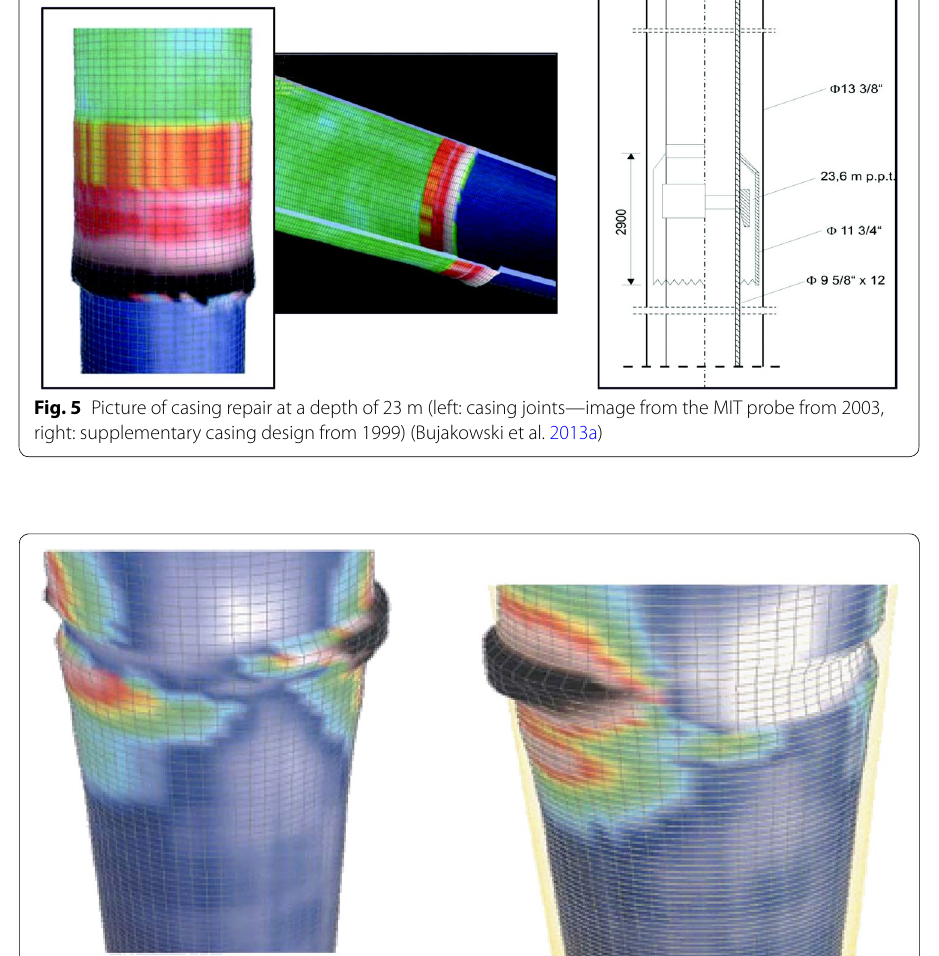
The zones listed above are periodically monitored using geophysical borehole